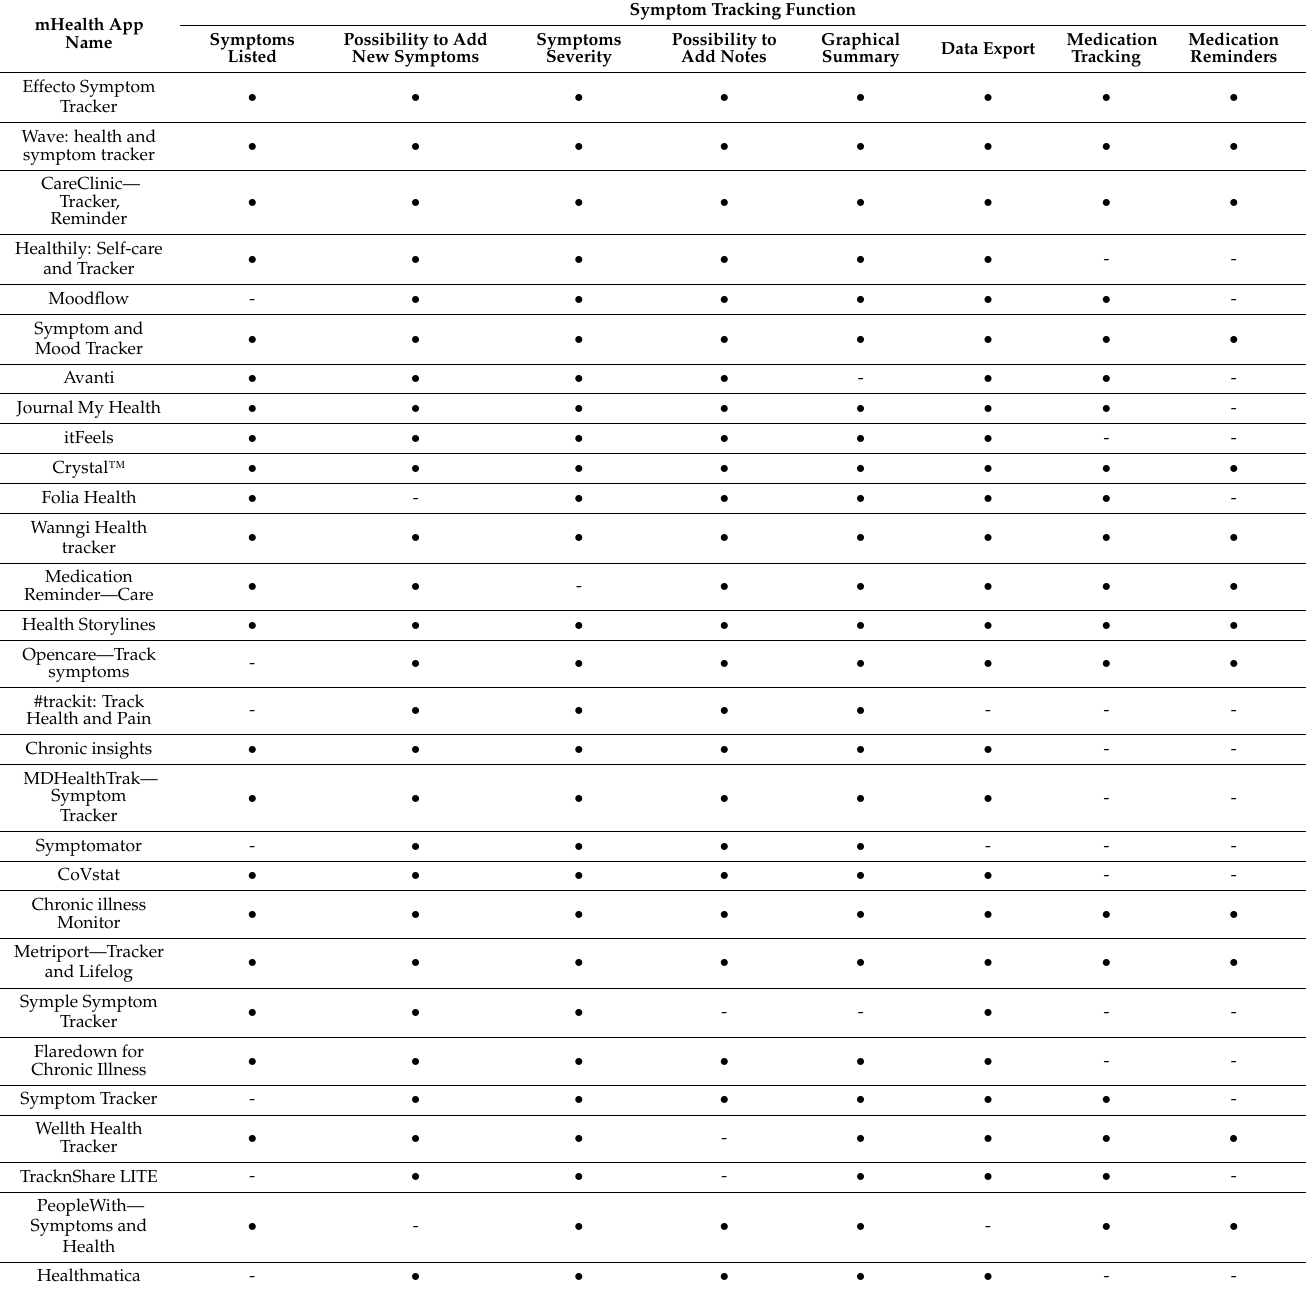
Table 2. mHealth apps symptom and medication tracking